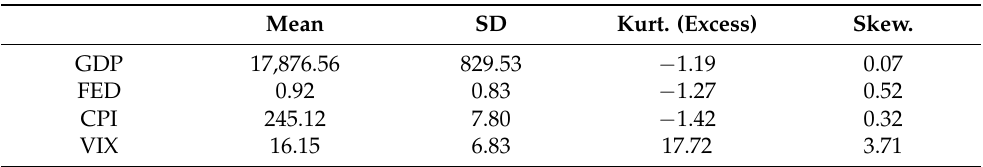
Figure 2. Monthly data as a function of the time period January 2014–May 2020: FED (effective federal funds rate) and VIX (volatility index) (percent) gross domestic product (GDP) and consumer price index (CPI) (US dollars). Source: Datastream. Table 2. Summary statistics of macroeconomic and financial time series from January 2014 to May 2020: FED and VIX (percent) GDP and CPI (US dollars). Source: Datastream.